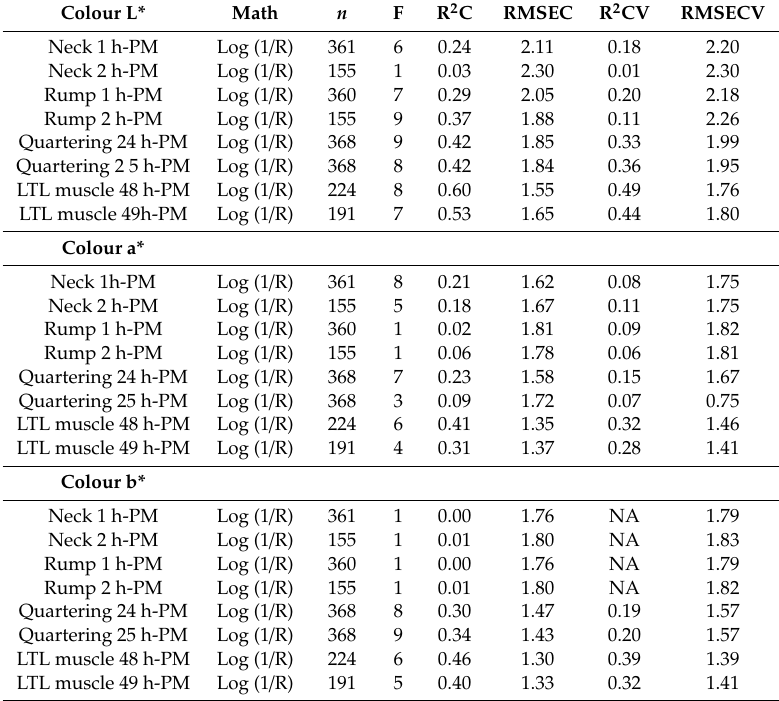
Table 5. Prediction of colour parameters of beef samples using Vis–NIR